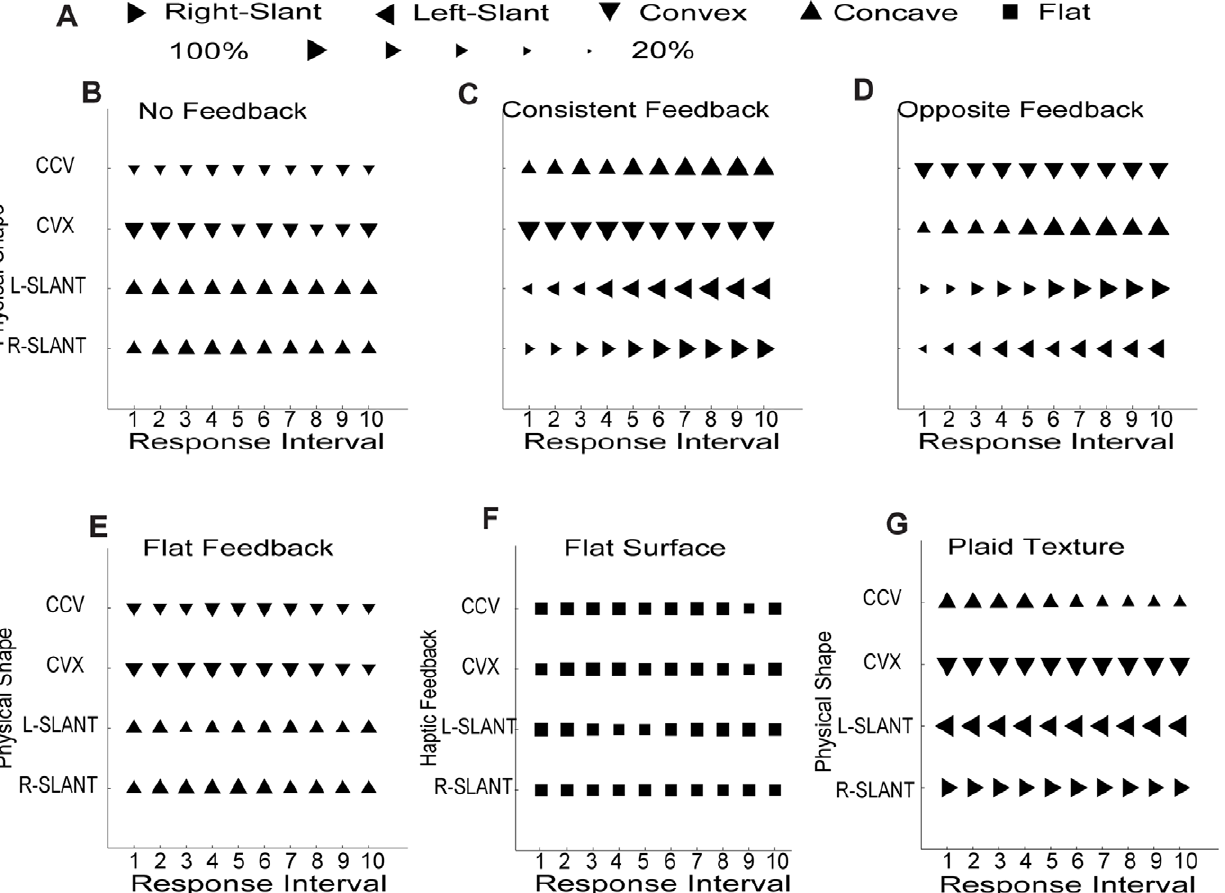
Figure 3. Results of Experiment 1. (A) Symbols: Most frequently reported shape (4 trials 6 5 observers). Size: Proportion of majority responses per condition. Data panels show majority shape reported at each prompt after a 10 sec interval when viewing sinusoidal corrugations covered by random-dot texture without haptic feedback (B), with haptic feedback consistent with simulated 3-D shape (C), and with haptic feedback opposite to 3-D shape (D). Without haptic feedback, the observers generally perceived concavities and convexities as convex, and both slants as concave; With haptic feedback consistent with the simulated surface, observers gradually started perceiving the concave and slanted surfaces ‘‘correctly’’. With the haptic feedback opposite to the simulated surface, the observers gradually perceived the surface indicated by the haptic feedback. (E) Shapes reported when viewing sinusoidal corrugations covered by random-dot texture with flat fronto-parallel haptic feedback. This feedback failed to modify the pre-training percept. (F) A flat fronto-parallel surface textured with random dots was tested with convex, concave, right-slant and left-slant haptic feedback. The curved or slanted haptic feedback did not alter the percept of the flat stimulus. (G) When the simulated surfaces were covered by a plaid texture, the observers could perceive the shape correctly, and haptic feedback opposite to the shape did not alter the visual percept.